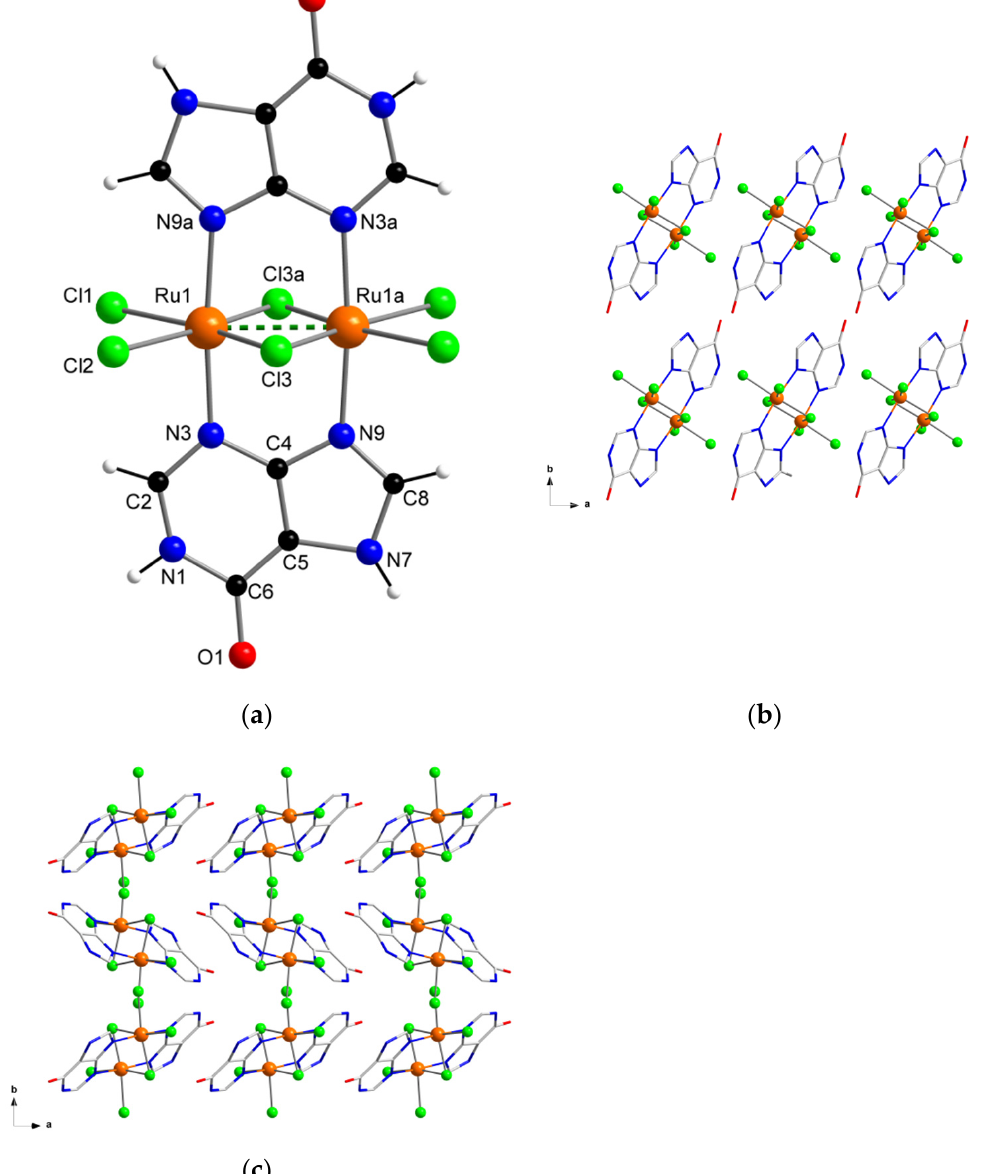
Figure 1. ( a ) Molecular structure of the [{Ru(µ-Cl)(µ-hpx)} 2 Cl 4 ] complex in 1a and 1b ; ( b ) view along the crystallographic c axis of a fragment of the crystal packing of 1a ; ( c ) view along the crystallographic c axis of a fragment of the crystal packing of 1b .